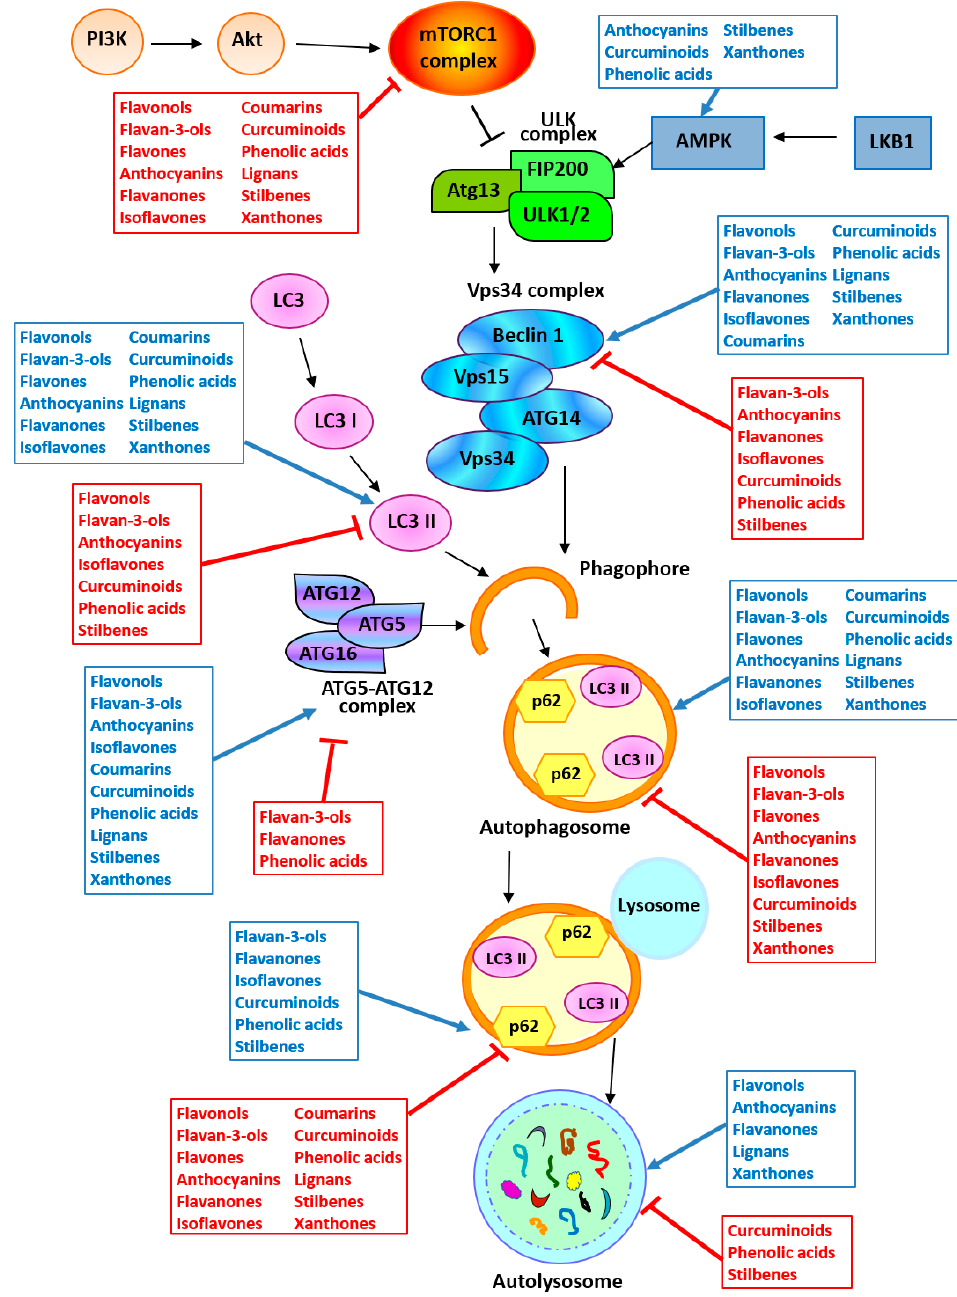
Figure 3. Targeting autophagy by polyphenols. The arrow and the inhibition arc indicate a positive and a negative activity of the polyphenols reported in the boxes, respectively. Abbreviations: AMPK, AMP-activated protein kinase; ATG, autophagy-related protein; Fip200, Fak family kinase interacting protein of 200 kD; LC3, Microtubule-Associated Protein 1 Light Chain 3; LKB1, serine / threonine liver kinase B1 (STK11); mTORC1, mammalian target of rapamycin complex 1; PI3K, phosphatidylinositol 3-kinase; ULK, unc-51-like autophagy-activating kinase; Vps, vacuolar protein sorting-associated protein.